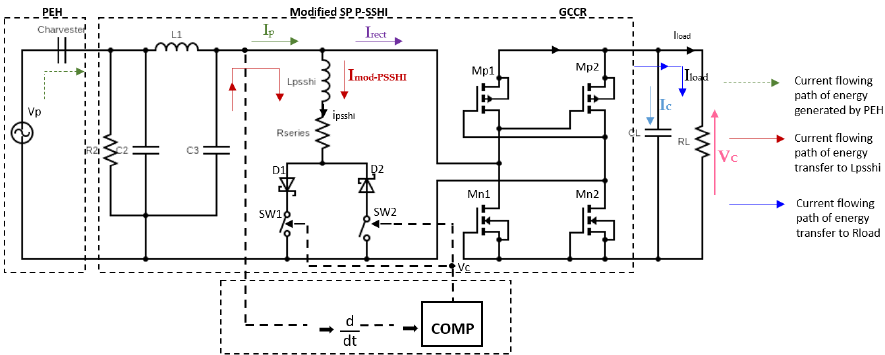
Figure 6. Schematic design concept of the proposed SP-PSSHI energy harvesting